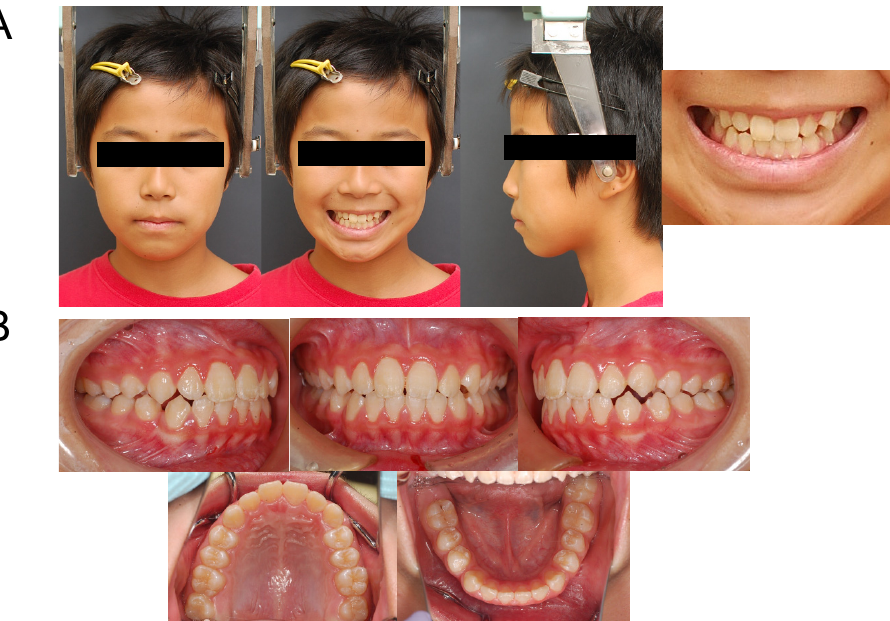
Figure 10. Facial photograph and intra-oral photograph of Case 2 at the end of the first stage of treatment; facial photograph and enlarged photograph of the mouth at the end of the first stage of treatment ( A ); intra-oral photograph at the end of first stage of treatment ( B ).